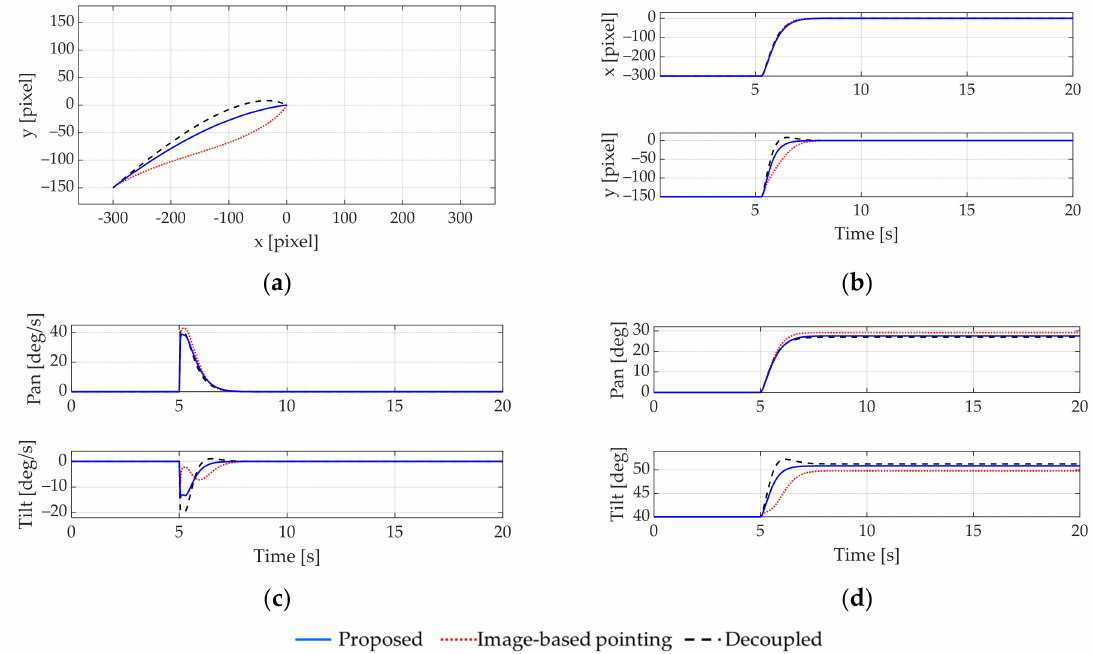
Figure 6. Simulation 2: Tracking a target point on the bottom-left corner of the image plane. ( a ) Tracking path on the image plane; ( b ) time response of each coordinate; ( c ) control signals; ( d ) orientations of the inner